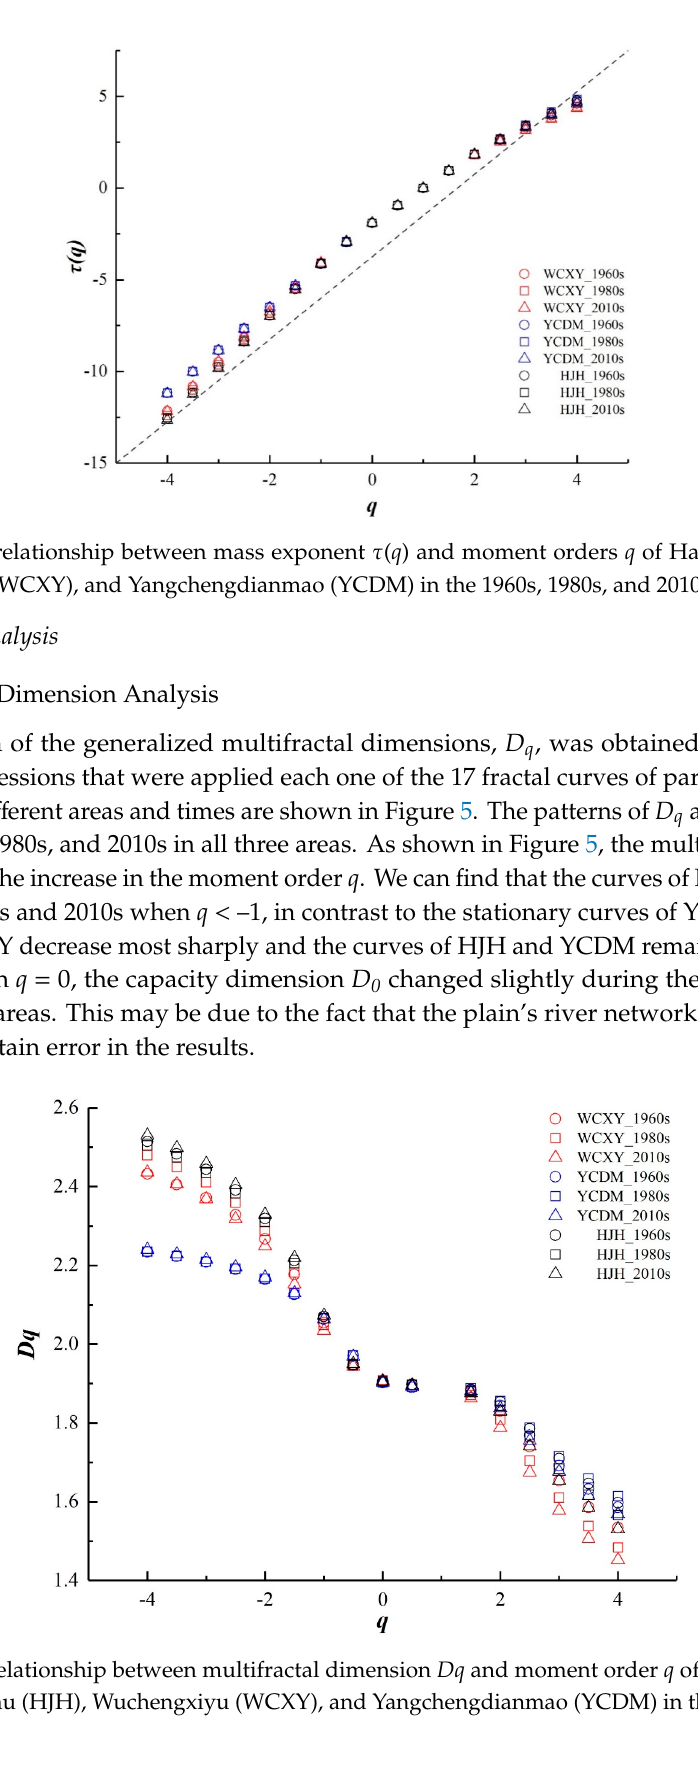
7 of 19 Figure 3. The ln( X q ( ε ) ) ~ ln( ε ) relationships of Wuchengxiyu (WCXY), Yangchengdianmao (YCDM), and Hanhjiahu (HJH) in 1960s–2010s under q from –4 to 4. The relationship between the mass exponents τ ( q ) and the moment order q is shown in Figure 4. The value of τ ( q ) increases with the value of q , the trend lines are upper convex curves during the